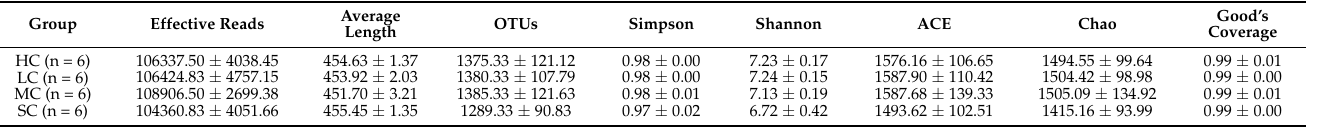
Figure 4. Flower plots of the caecal microbiota of laying hens reared in HC, LC, MC, and SC (based on OTUs). Each circle in the Venn diagram corresponds to a group that is represented by the same colour. The numbers in the overlapping areas indicate the number of bacterial OTUs shared between the respective groups. The numbers in the individual areas indicate the number of bacterial OTUs unique to that group. HC, huge cage; LC, large cage; MC, medium cage; SC, small cage. Table 4. Diversity estimation of the 16S rDNA gene libraries of the caecal microbiota in laying hens from different groups 1